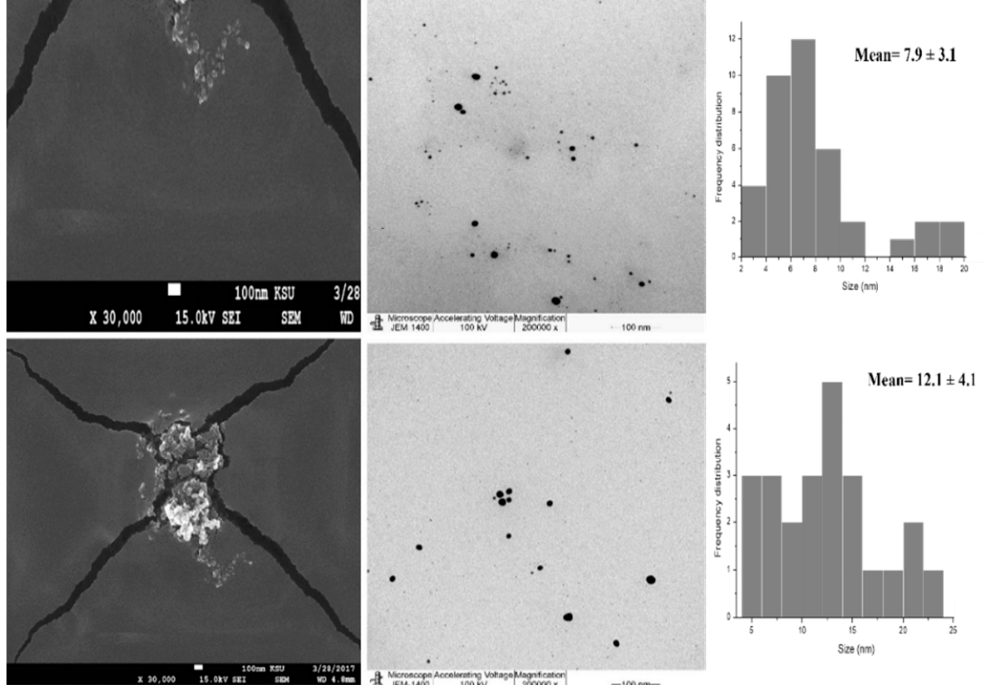
Figure 4. SEM image ( left side ) and the corresponding TEM image ( right side ) of AgNPs capped with the biomolecules from Acacia arabica gum Scale bar represents 100 nm and magnification of 30,000 and 200,000 for SEM and TEM images, respectively. Size measurements were analyzed by ImageJ software constructed from TEM micrographs.